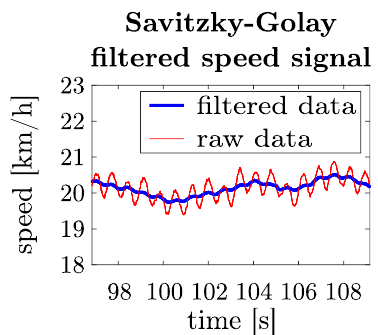
Figure 6. Speed data smoothed with the Savitzky–Golay FIR filter compared to the recorded